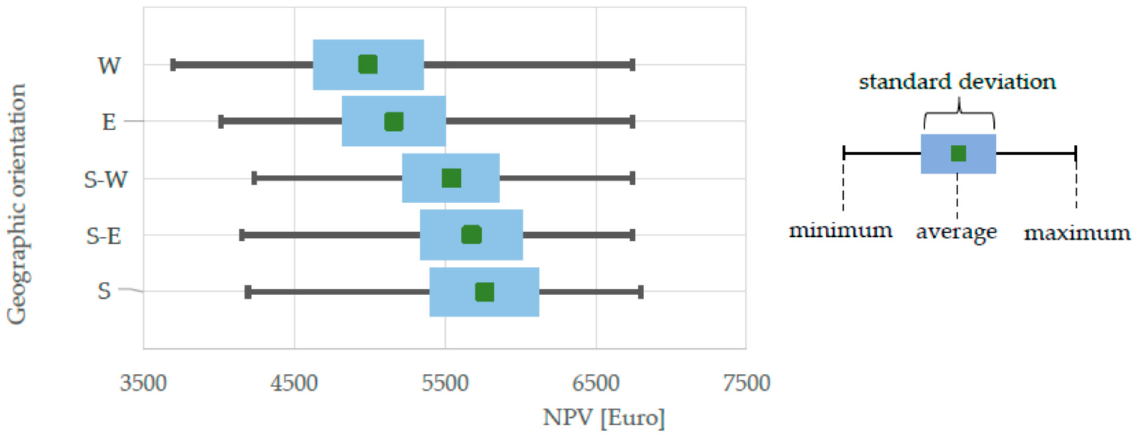
Figure 5. Statistical NPV values on a macroeconomic level depending on the installation orientation. Another parameter influencing the economic efficiency of energy production while using PV panels is roof inclination, on which the installation is fixed (Figure 6). The great- est NPV values were obtained in the case of flat roofs. This type of roof construction ena- bles optimal solar panel orientation, regardless of roof orientation. In the case of flat roofs, it is necessary to fix the PV installation on a supporting construction at a 30-degree angle.